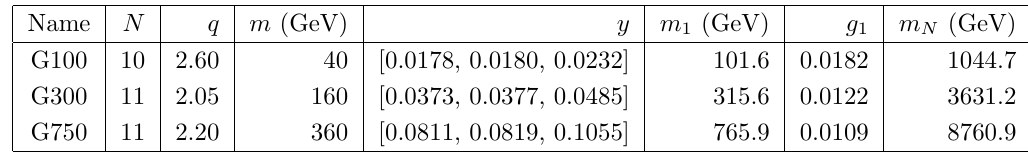
Table 2 . Benchmark points (BPs) for the generalised clockwork model (LCW1). First column: BP name. Next 4 columns: model input parameters. Last 3 columns: mass of the lightest CW neutrino; its coupling to weak current; and mass of the heaviest CW